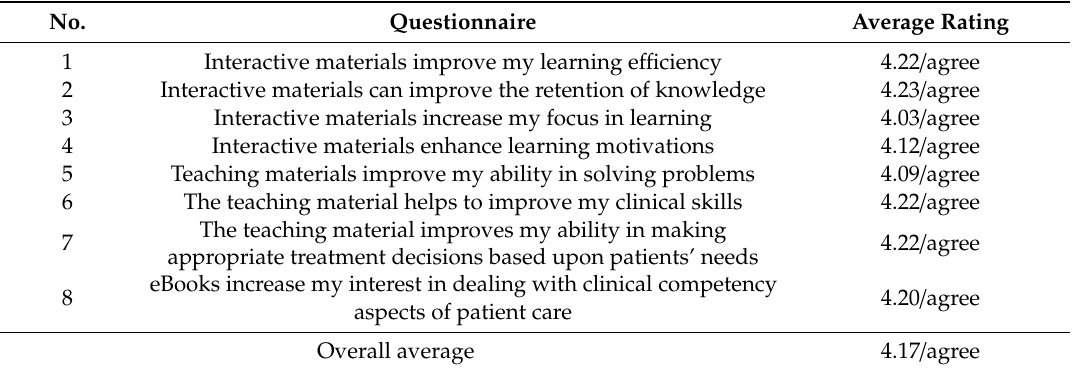
Table 2. Students’ responses on the quality of teaching materials and how helpful the eBooks were when they were performing clinical competencies in practical settings. ( n = 50).